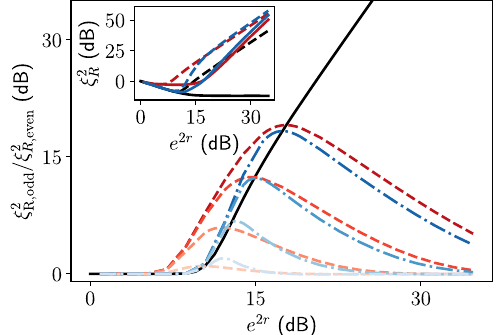
FIG. 13. Ratio between the steady-state Wineland parameters for even and odd N without local dissipation (solid black line), with local dephasing (dashed lines), and with local relaxation (dash-dotted lines) calculated using the quantum master equation Eq. (11) of the main text. The parameters are from top to bottom: γ Γ ¼ ð 0 . 00005 ; 0 . 0005 ; 0 . 005 ; 0 . 05 Þ and γ = Γ ¼ 0 for the red ϕ = rel = Γ ¼ ð 0 . 0001 ; 0 . 001 ; 0 . 01 ; 0 . 1 Þ and γ ϕ = Γ ¼ 0 for curves and γ rel the blue curves. Inset: corresponding plot of the Wineland parameters for N ¼ 30 (solid lines) vs N ¼ 31 (dashed lines) without local dissipation (black lines), with local dephasing (red = Γ ¼ 0 ), and with local relaxation lines, γ ϕ = Γ ¼ 0 . 00005 , γ rel = Γ ¼ 0 . 0001 (blue lines, γ ϕ = Γ ¼ 0 , γ rel